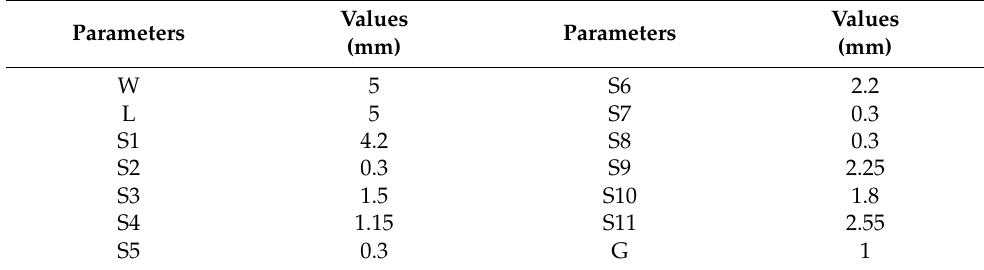
Table 2. The optimized parameters of the proposed